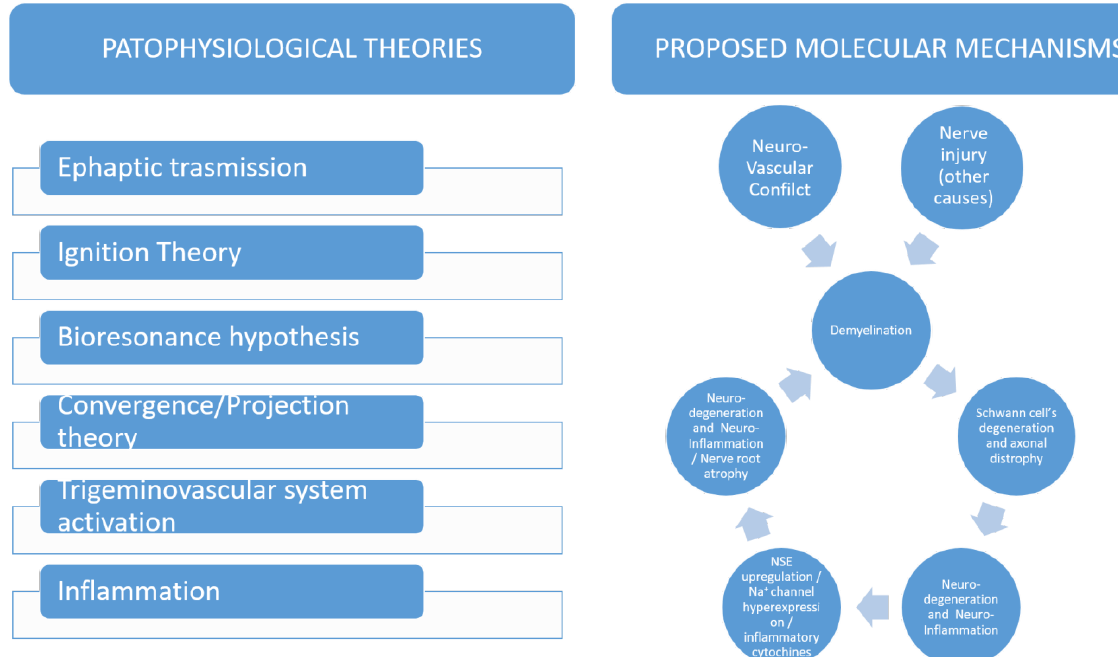
Figure 1. Summary of the pathophysiological theories and molecular mechanisms involved in TN pathogenesis.